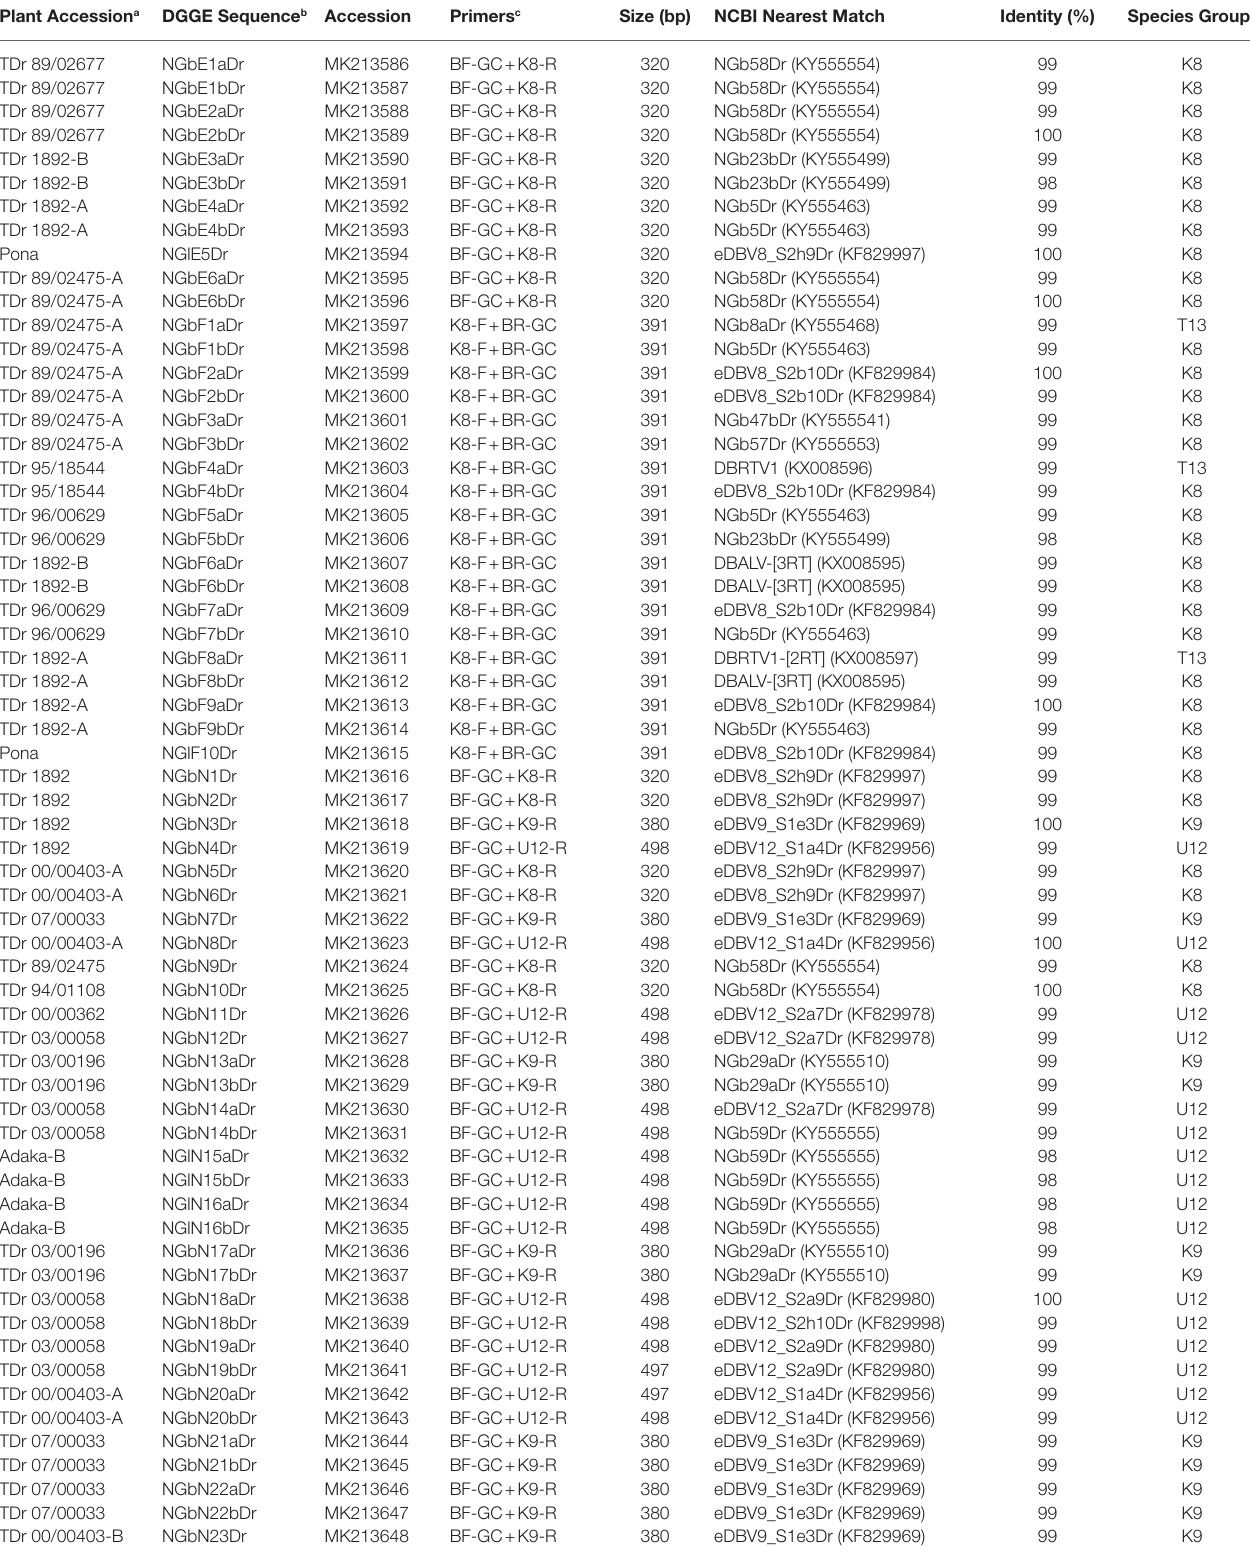
TABLE 1 | BLAST analysis of partial RT-RNaseH sequences cloned from DGGE